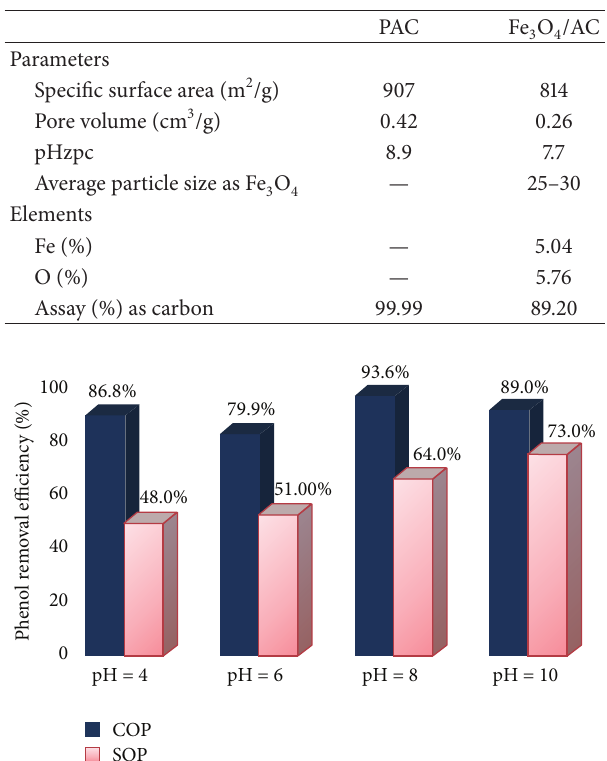
O coated on activated carbon. 3 4